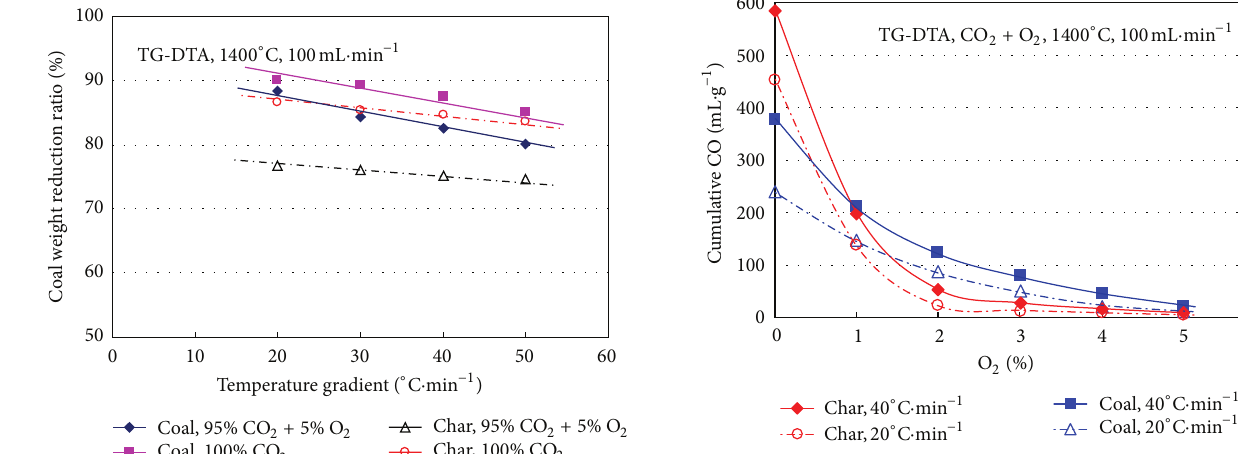
Figure29:CumulativeCOgasversusO 2 %fordifferenttemperature gradients during 20 to 1400 ∘ C (0 to 70